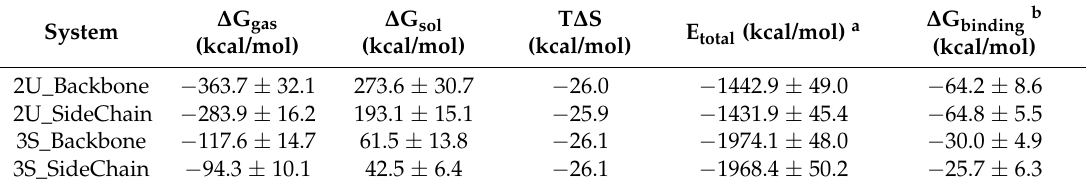
Table 1. Binding energies for 2U_Backbone, 2U_SideChain, 3S_Backbone, and 3S_SideChain gammabody-A β